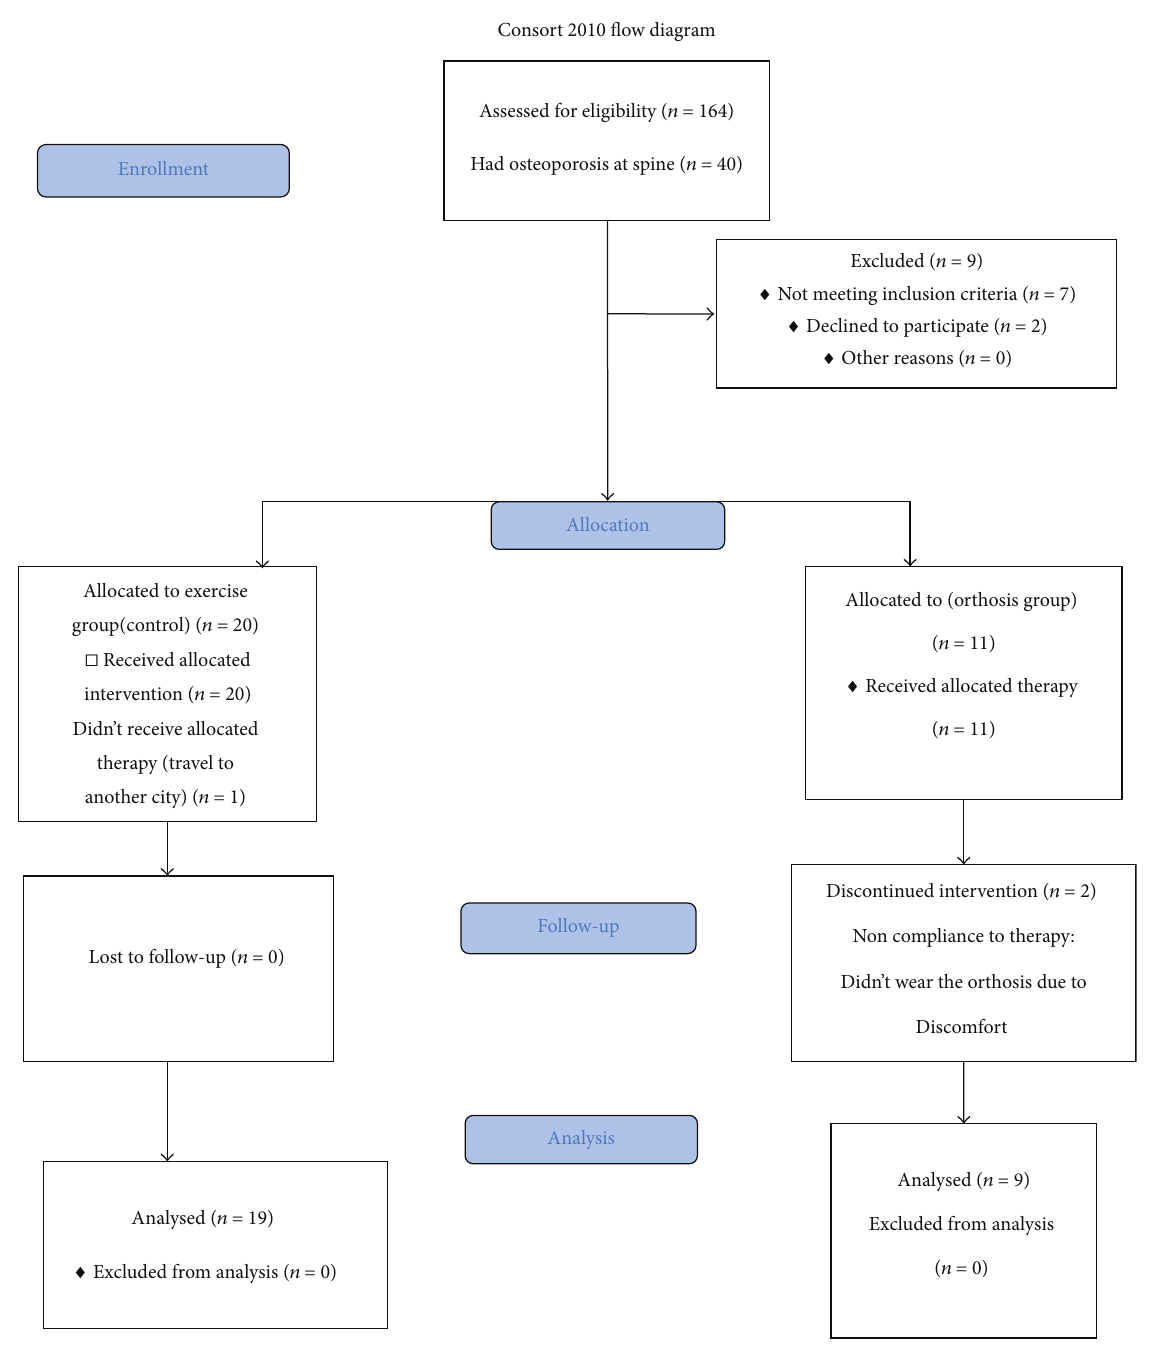
Figure 3: CONSORT 2010 Flow